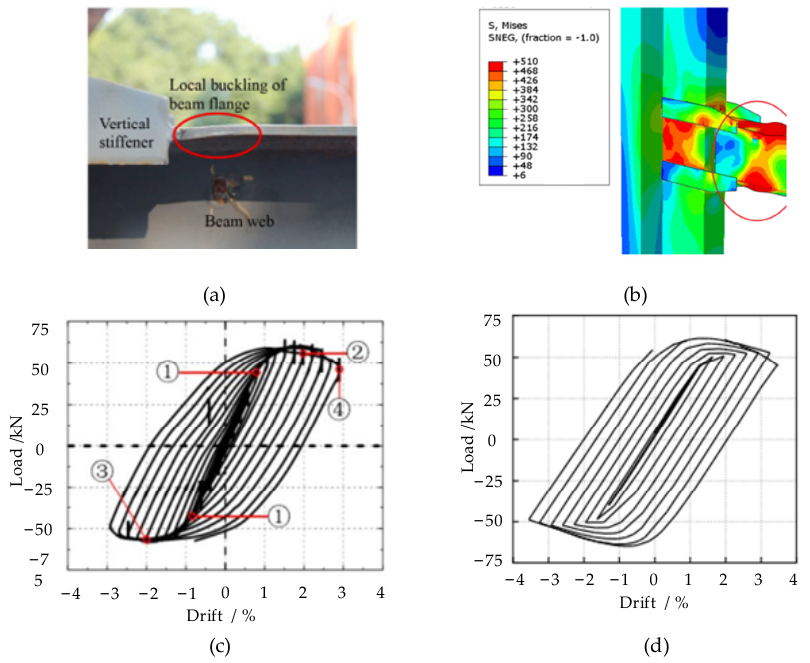
Figure 4. Test results and finite element model validation. ( a ) Deformation of test; ( b ) Deformation of FE (unit: MPa); ( c ) Hysteresis curves from test; ( d ) Hysteresis curves from FE.